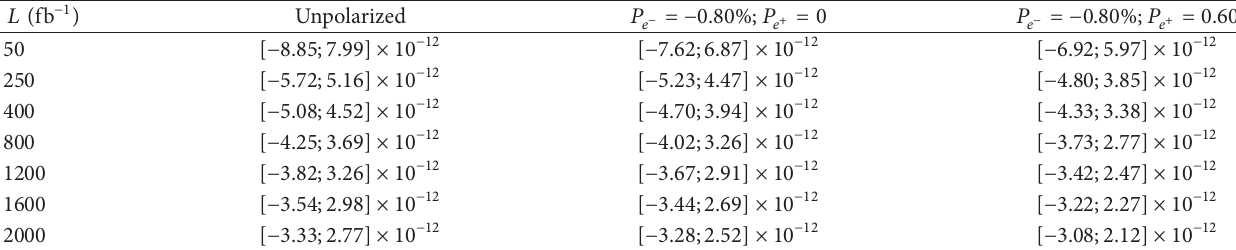
Table 6: Sensitivity of 𝑓 𝑆1 /Λ 4 at 95% CL for √𝑠 = 3 TeV in units of GeV −4 .